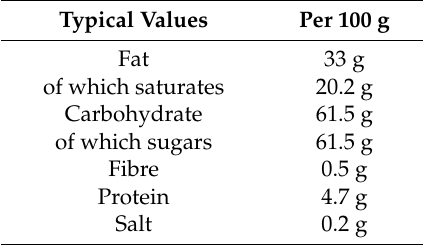
Table 1. White chocolate composition.